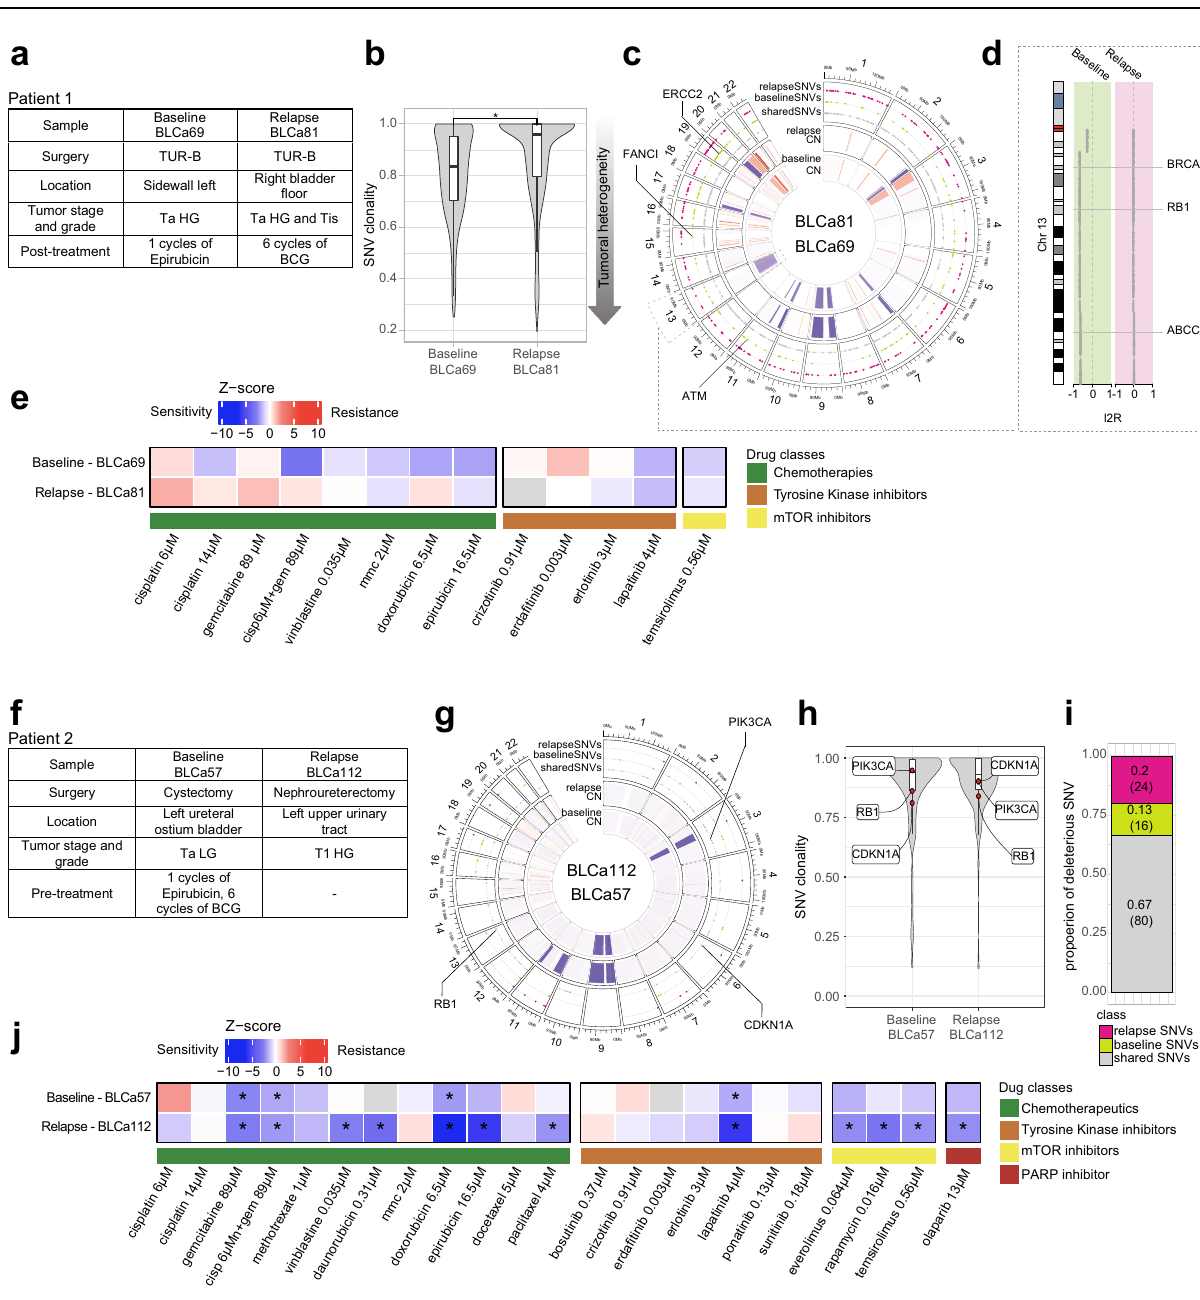
are in gray. One-way ANOVA with Dunnet ’ s multiple comparison test between treatments and vehicle (raw data are provided in Supplementary Data 6). f Clinical and pathological information of patient 2. g CN and point mutations pro fi les between PDOs from the baseline and the relapse of patients 2. Relevant genetic alterations are highlighted. h SNV clonality pro fi les of baseline PDOs and relapse PDOs with a highlight for PI3KCA , RB1 , and CDKN1A genes. i Proportion of dele- teriousSNVssharedandnotsharedbetweenbaselineandrelapsePDOs. j Resultsof one PDO drug screen assay on patient 2. One-way ANOVA with Dunnet ’ s multiple comparison test between treatments and vehicle, *z-score ≤− 1.5 and adjusted p - value ≤ 0.05 (raw data are provided in Supplementary Data 6). BCG Bacillus Calmette – Guérin, cisp cisplatin, Chr chromosome, Tis carcinoma in situ, gem gemcitabine, TUR-B transurethral resection of the bladder. HG high-grade, LG